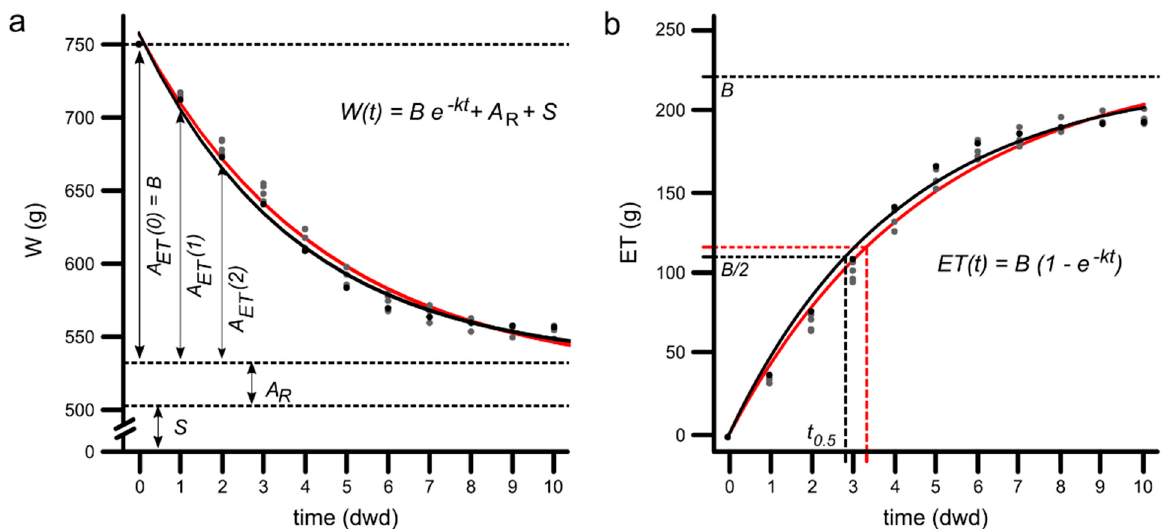
Figure 2. ( a ) Empirical model representing evapotranspiration over time and the empirical model adjustment. Weight ( W ) of the PPS along the days of water deficit (dwd). Sum of dry weight substrate, pot, and plant weight ( S ), residual water ( A R ), evapotranspirable water ( A ET ), and potential evapotranspiration ( B ) of plants at field-capacity conditions. ( b ) Mathematical analysis for modeling ET ( t ) as a function of time. The parameter t 0.5 is the time required for the PPS to halve the potentially evapotranspirable water.